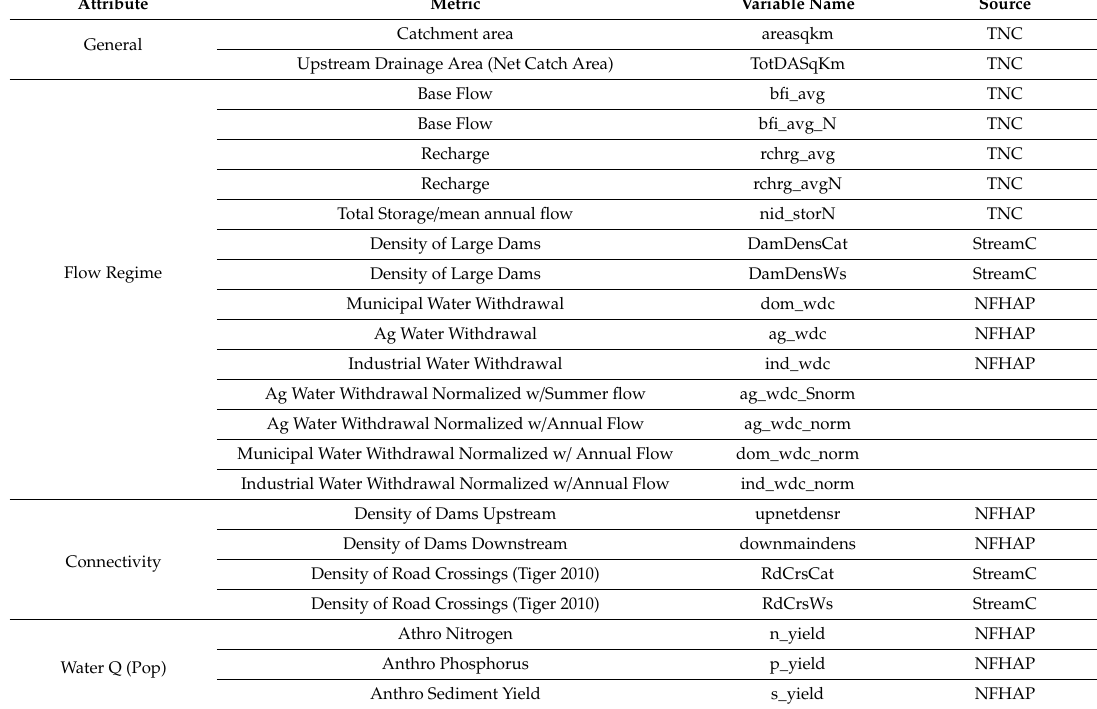
Table A1. Full list of predictors, showing each variable’s thematic grouping and the source for each data set.